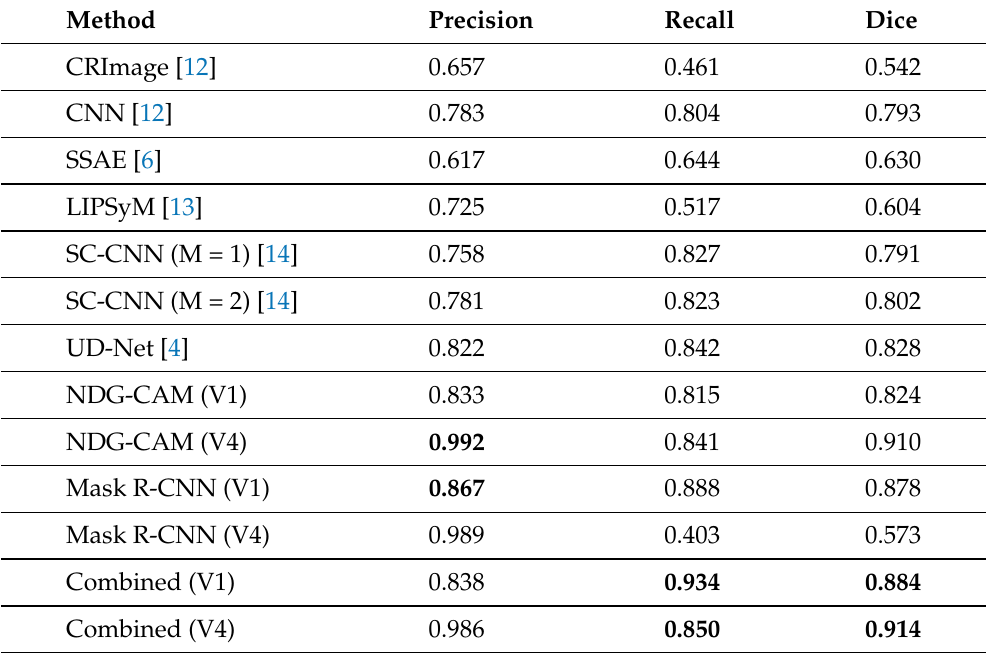
Table 3. Comparison of detection methods, extending the one proposed by Alom et al. [4] and Sirinukunwattana et al. [14].